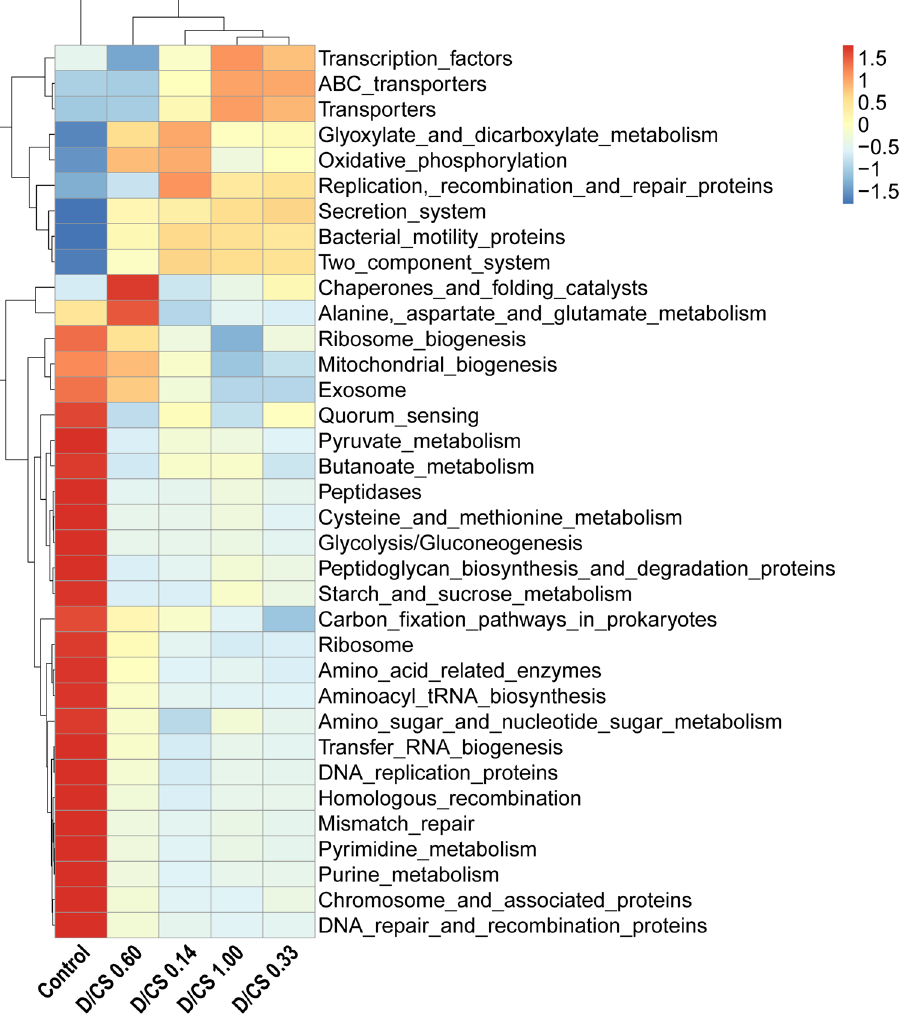
Figure 4. Cluster analysis of the functional relative abundance of Tax4Fun. According to the functional annotation and abundance information of the samples in the database, the top 35 functions and their abundance information in each sample were selected to draw the thermal map ( n =